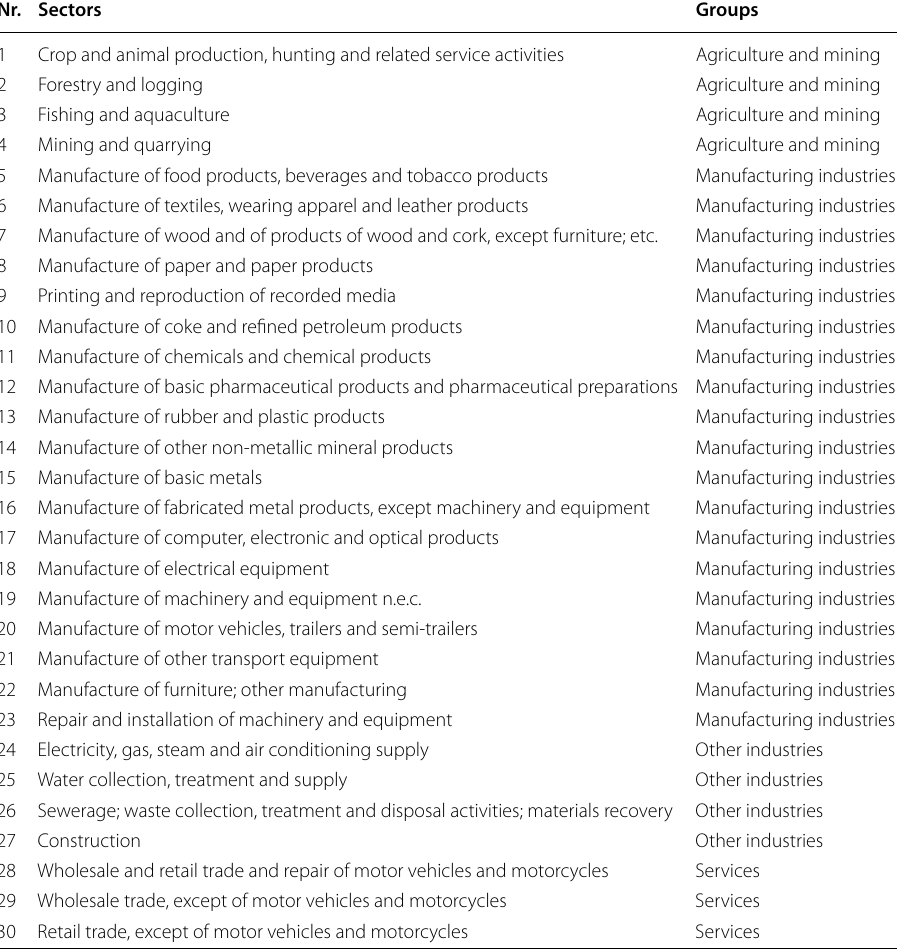
Table 5 The list of sectors in WIOD Nr.